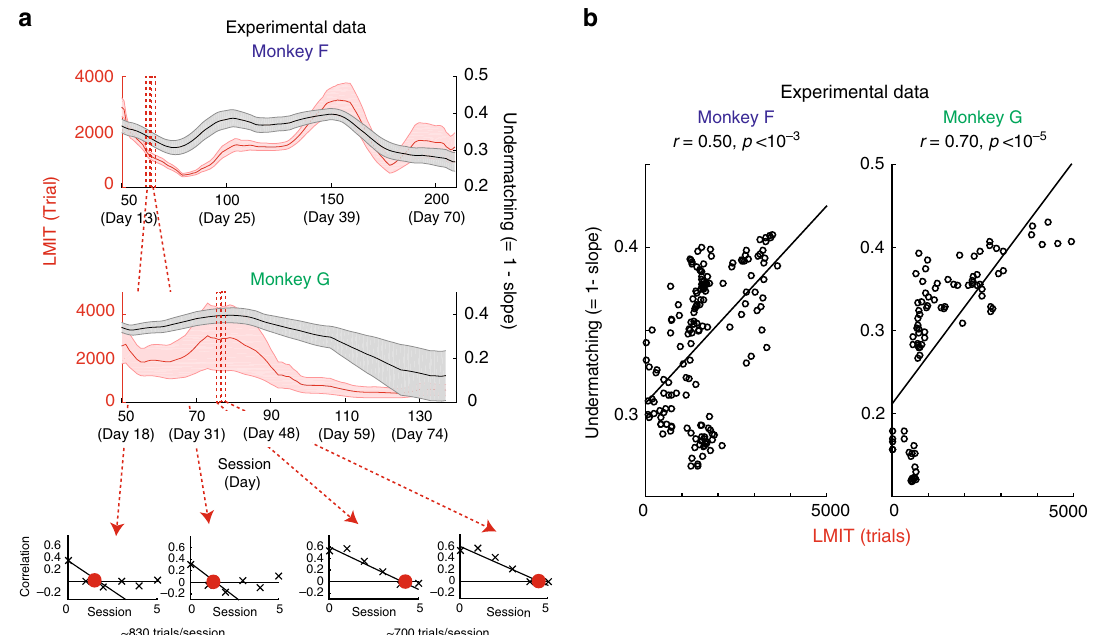
Fig. 7 Measuring the LMIT in experimental data and showing correlations with undermatching. a We estimated the LMIT directly in experimental data. Both LMIT (red) and deviation from the matching law (black) vary over time for both monkeys. In the small insets at the bottom, we show four samples of the lagged correlation between color choice bias and color reward imbalance (the same plots as the ones in Fig. 6b, but now for the real data). The degree of undermatching seems to be correlated with the LMIT, as predicted by the theory. This impression is con fi rmed by the analysis in b , where we plotted the degree of undermatching as a function of the LMIT. The correlations between the two quantities are highly signi fi cant for both monkeys (conservative piece-wise permutation test: p < 10 − 3 for monkey F and p < 10 − 5 for monkey G). See the Methods section for the details of the permutation test. See also Supplementary Figure 14. Notice that the LMIT is a measure of integration time constant that does not require any assumption about the underlying